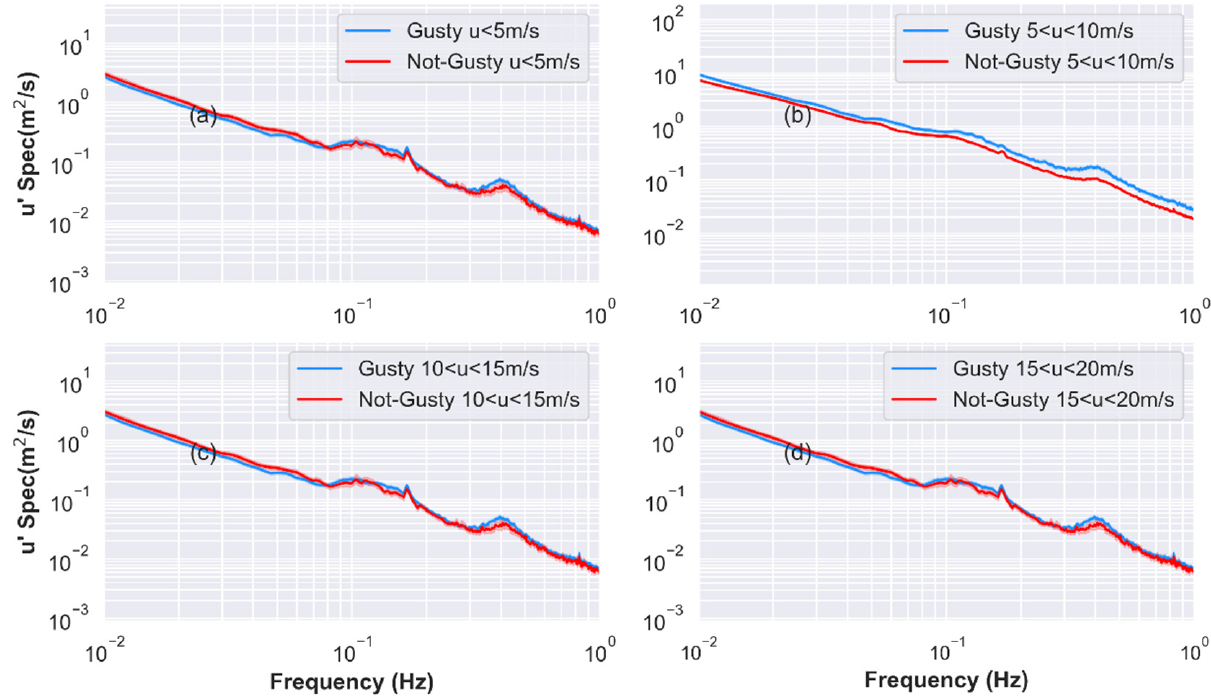
Figure 11. Power spectrum of 𝑢′ under the same wind conditions. ( a ) 0 < 𝑈 < 5 m/s, ( b ) 5 < 𝑈 < 10 m/s, ( c ) 10 < 𝑈 < 15 m/s, and ( d ) 15 < 𝑈 < 20 m/s. The blue represents the gusty runs, and the red represents the not-gusty runs. The positive means the downward momentum fluxes, and the negative means the upward momentum fluxes. Shaded area is 95% confidence interval for the 𝑢’ spec.